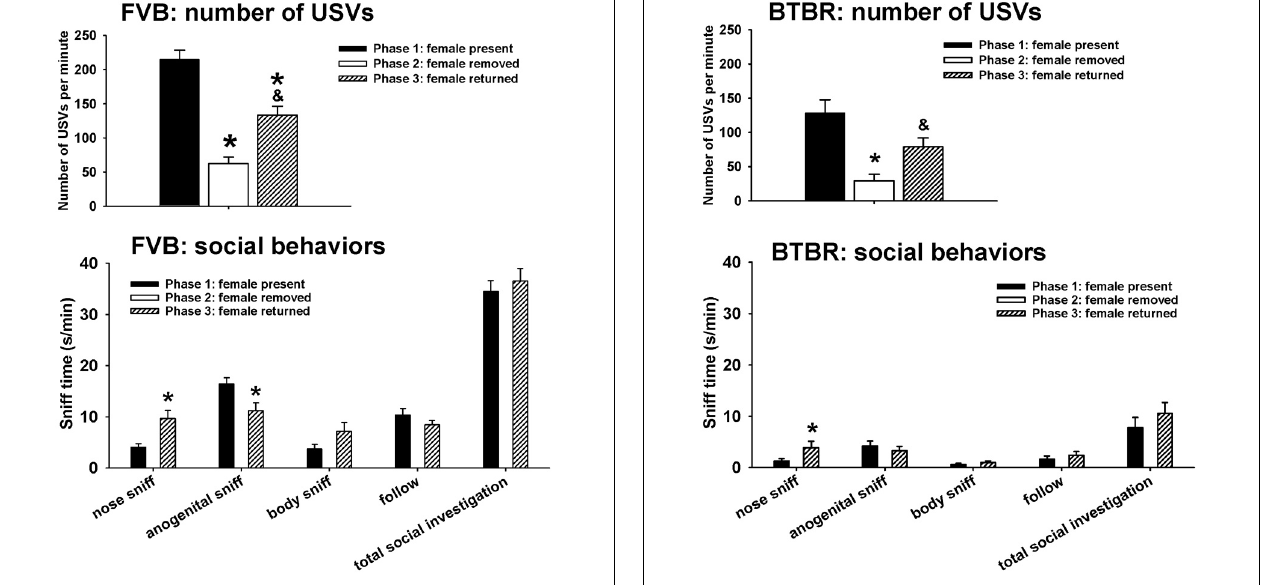
FIGURE 2 | USVs and social behaviors in FVB males in phases 1, 2, and 3. USVs were detected from 12 out of 12 FVB in phase 1, 12 out of 12 FVB in phase 2, and 10 out of 10 FVB in phase 3. All animals were included in call number analysis and behavioral comparisons. FVB emitted fewer USVs in phase 2 and phase 3 than in phase 1, and more in phase 3 than in phase 2. Analysis of behavioral parameters revealed no significant differences between phase 1 and phase 3, on durations of body sniffing, follow, and total social investigation. FVB displayed higher levels of nose-to-nose sniffing and lower levels of anogenital sniffing in phase 3 than in phase 1. ∗ p < 0 . 05 vs. phase 1; & p < 0 . 05 vs. phase 2.